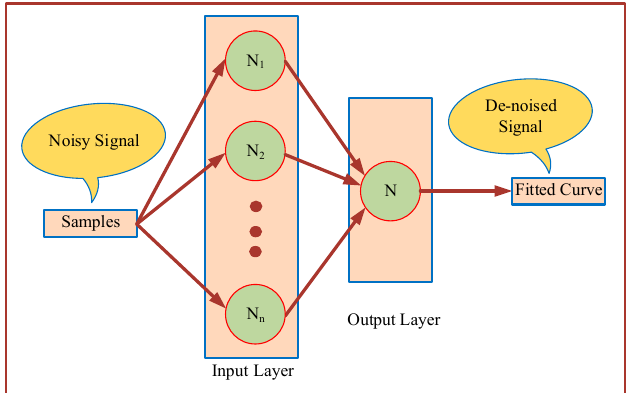
Energies 2019 , 12 , x FOR PEER REVIEW Figure 3. Structure of the ANN in the proposed method. Figure 3. Structure of the ANN in the proposed method.